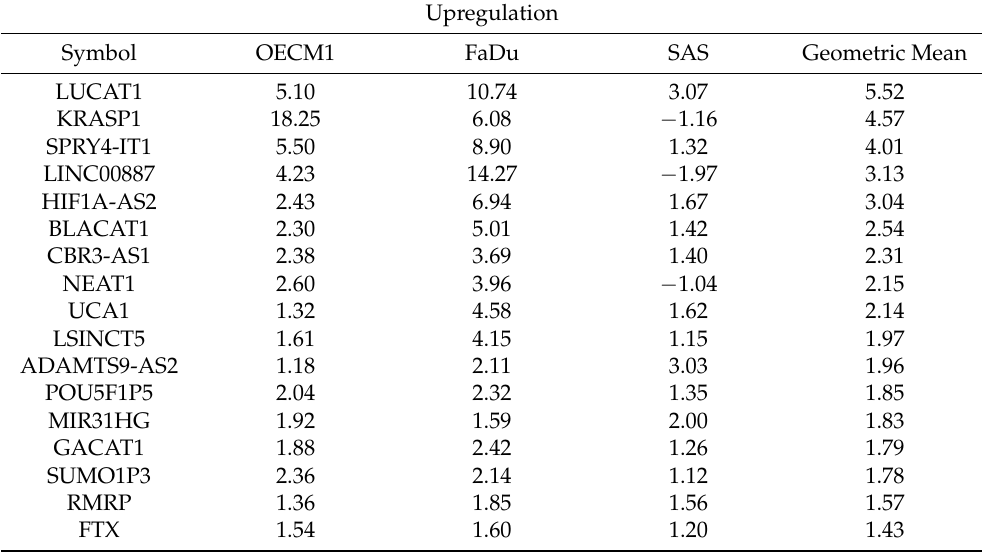
Table 1. List of lncRNAs regulated by